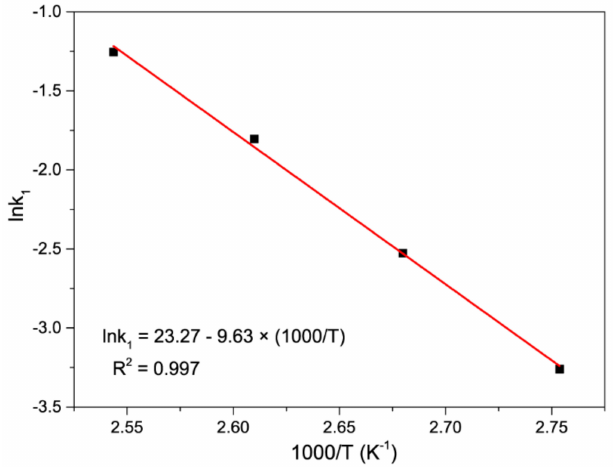
Figure 4. Arrhenius plot for epimerization of glucose over 13.3PMo / NH 2 -SBA-15.